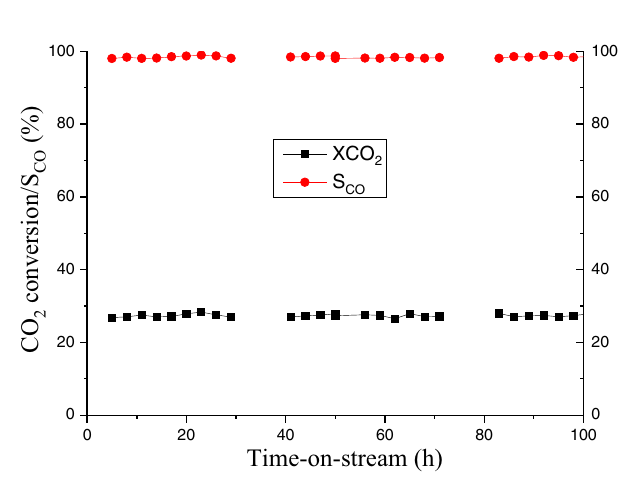
Fig. 3 | Catalytic stability test for CO 2 conversion (XCO 2 ) and CO selectivity (S CO ). Reaction conditions: 300mg of 10Cu@SiO 2 -PHM, 100NmL/min of H 2 /CO 2 (3:1) gas mixture, gas hourly space velocity (GHSV)=15,000h − 1 , temperature ( T )=400°C, pressure ( P